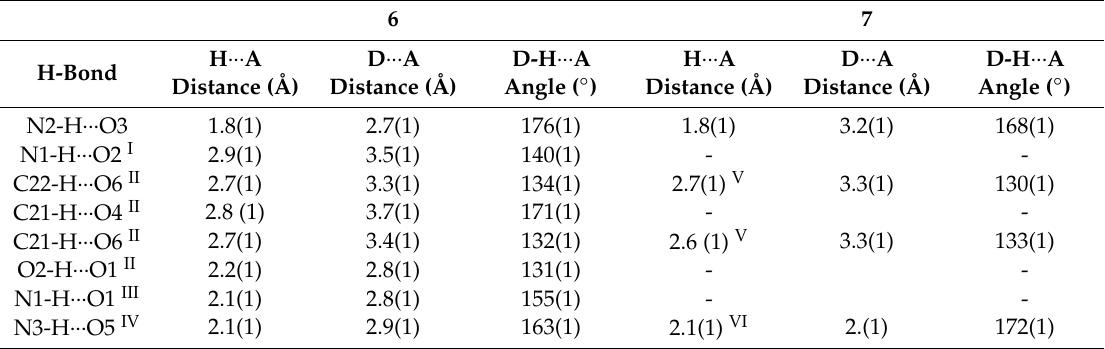
Table 5. Hydrogen-bonds geometry of 6 and 7 (arbitrary atom-numbering scheme used in Figure 4).